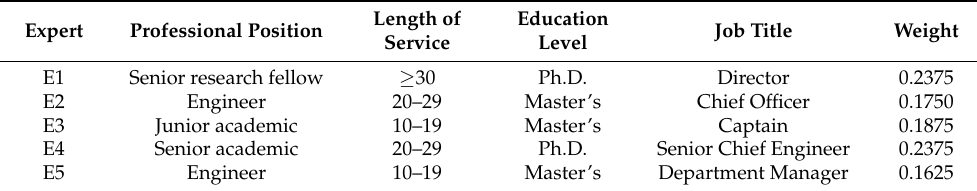
Table 4. The calculation results of expert